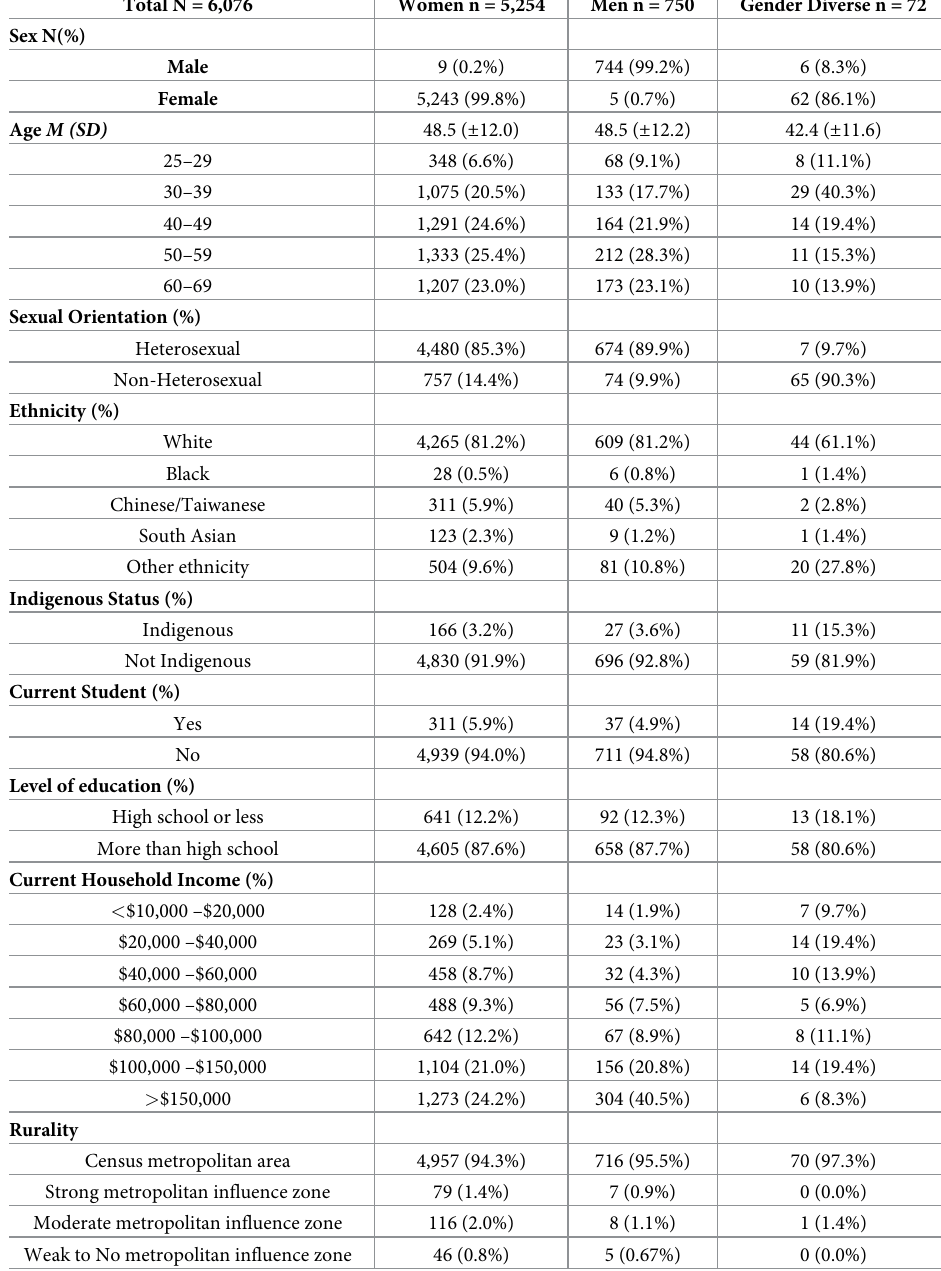
Table 1. Demographic information of survey